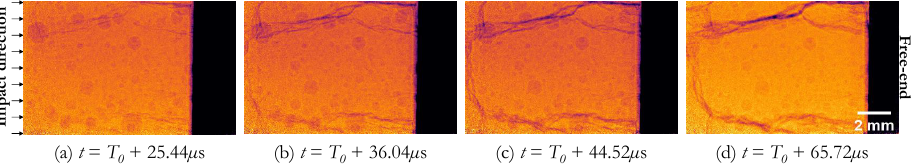
Figure 3: XPC radiographs captured during in-situ edge-on-impact test on an ultra-high strength concrete sample impacted with 80 m / s, showing the initiation of tensile cracks at free-end and progressive coalescence to form spall fragments. (Impact direction is from the right hand side.)